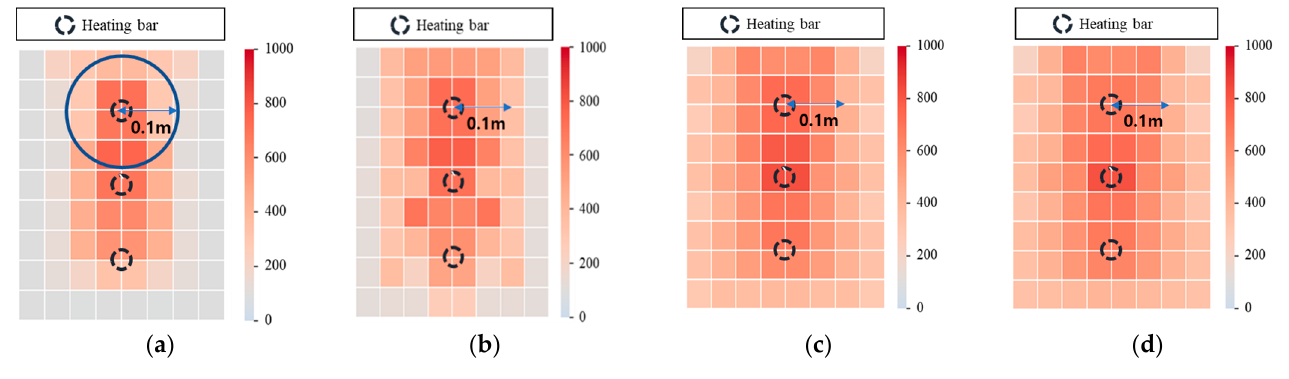
Figure 5. Temperature of heating element.